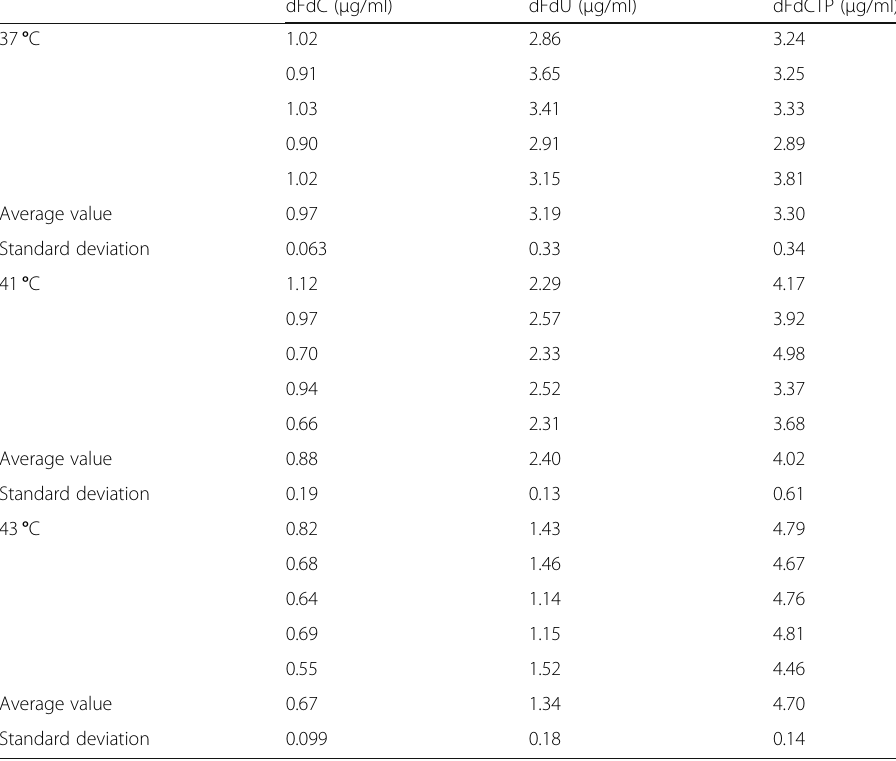
Table 4 Effects of hyperthermia on changes in the concentration of dFdC and its metabolites dFdC ( μ